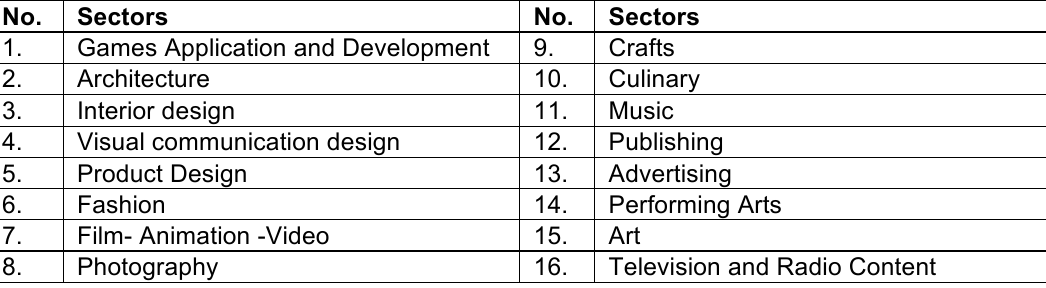
Table 1: Creative Industry Subsectors According to